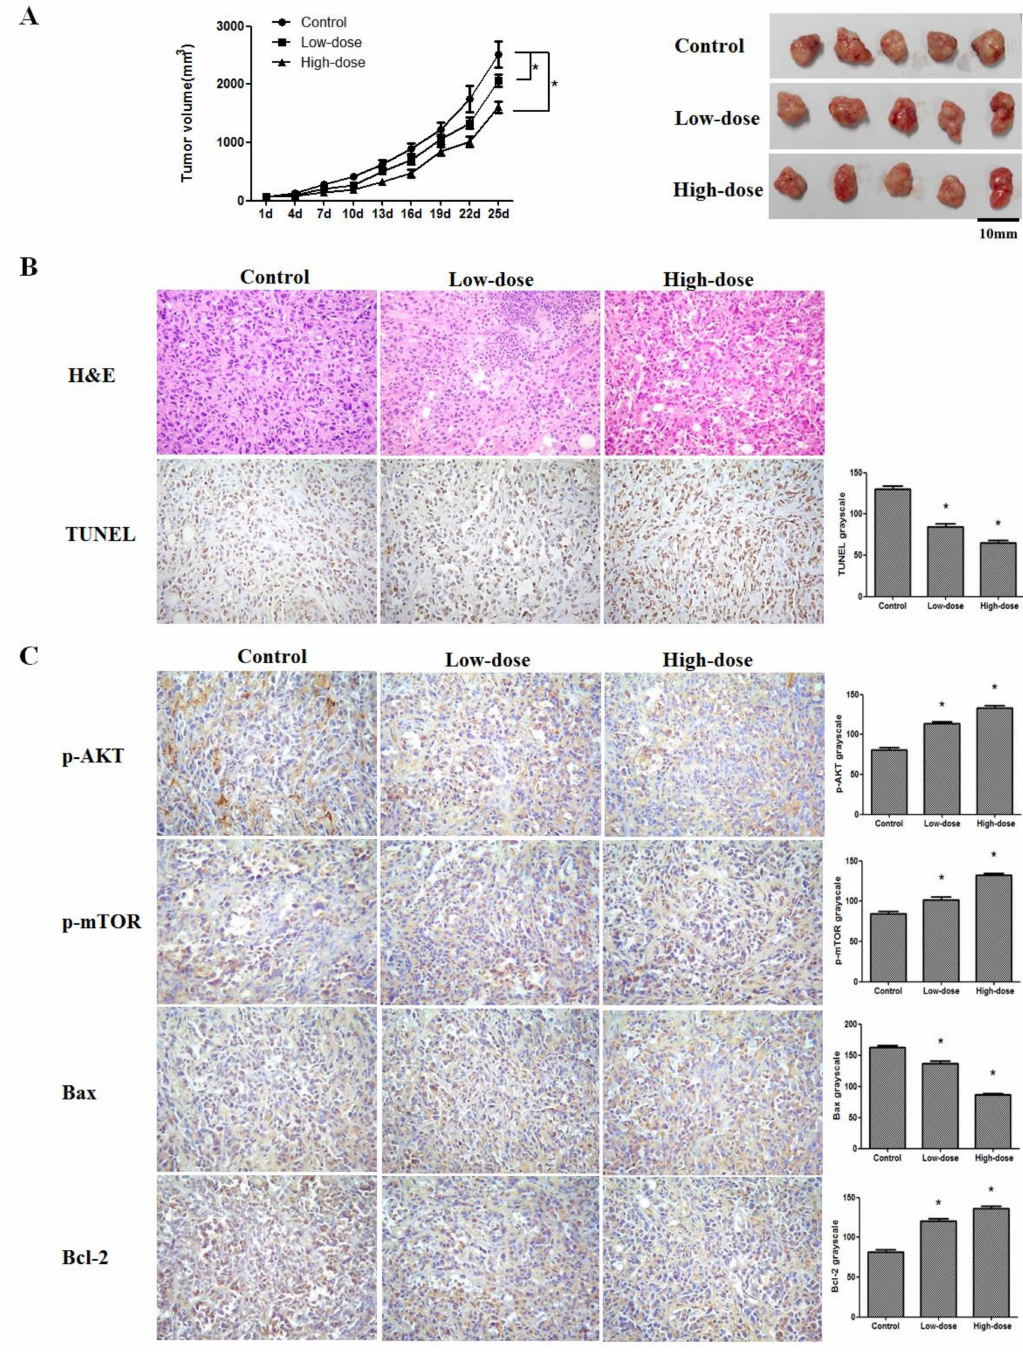
Figure 6. Effects of 20(S)-PPD on the nude mice xenograft of MCF-7 cells in vivo. ( A ) Tumor growth curves of the control and 20(S)-PPD (50,100 mg/kg) treatment groups were drawn by measuring and calculating tumor volume once every three days. ( B ) Excised human breast tumor images from the experimental group. ( C ) H&E staining, TUNEL assay, and immunohistochemistry were used to detect DNA damage, apoptosis, and p-AKT, p-mTOR, Bax, and Bcl-2 expression in tumor xenograft tissues (100 × ), respectively, and these data were represented by grayscale: the darker the grayscale is, the lower the protein expression. All data presented were represented as mean ± S.D. * p < 0.05 compared to the control